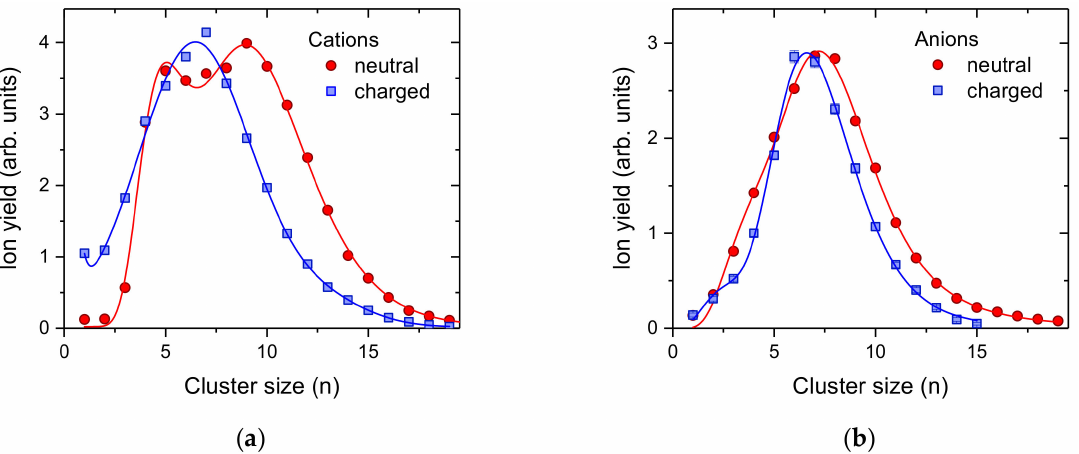
Figure 5. Cluster size distributions of positively ( a ) and negatively ( b ) charged of C 60 clusters formed upon pickup into pre-charged helium droplets (blue squares) and electron bombardment of neutral He droplets doped with C 60 . In the case of cations, the electron energy was set to 50 eV and the mass spectrum for anions was set to 22 eV, at which resonant formation of He* − [61] is essential for the production of anionic dopant